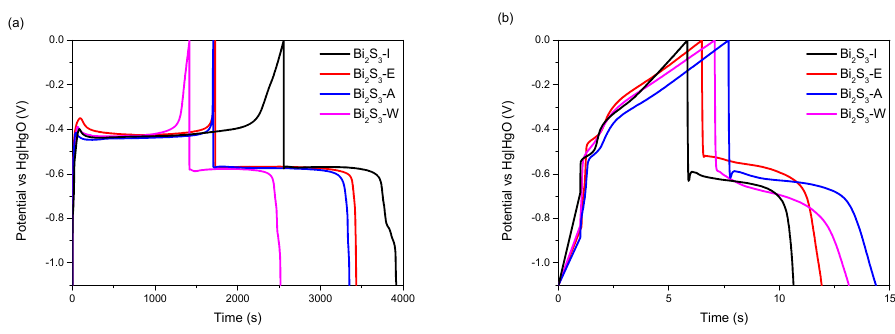
Figure 6. Charge–discharge profiles of the bismuth sulfides recorded at 0.5 A g − 1 ( a ) and 10 A g − 1 ( b ). The relationships between the specific capacity and scan rate are presented in Figure 7a, while the specific capacity vs. discharge current density relationship is shown in Figure 7b.